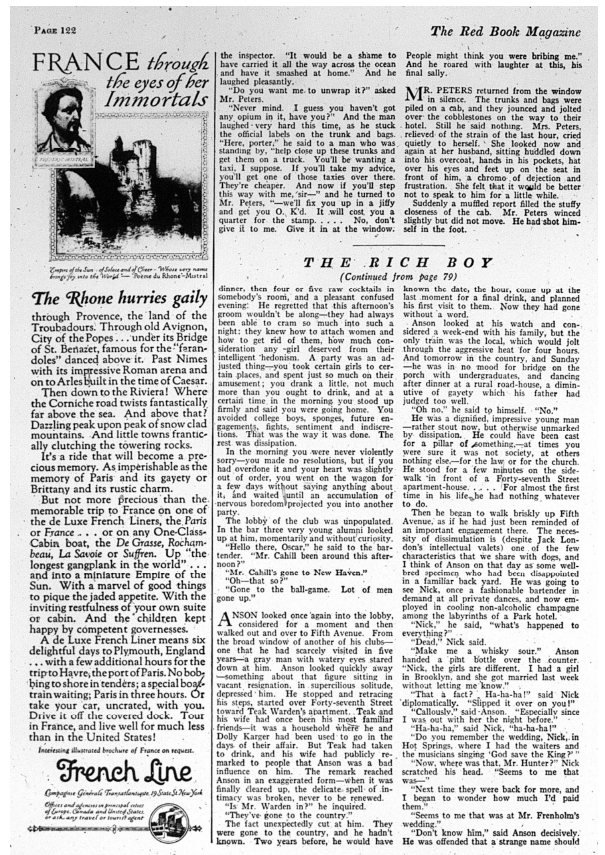
Figure 3. “The Rich Boy” as it first appeared in the February 1926 issue of Red Book Magazine (Fitzgerald 1926b), p. 122.